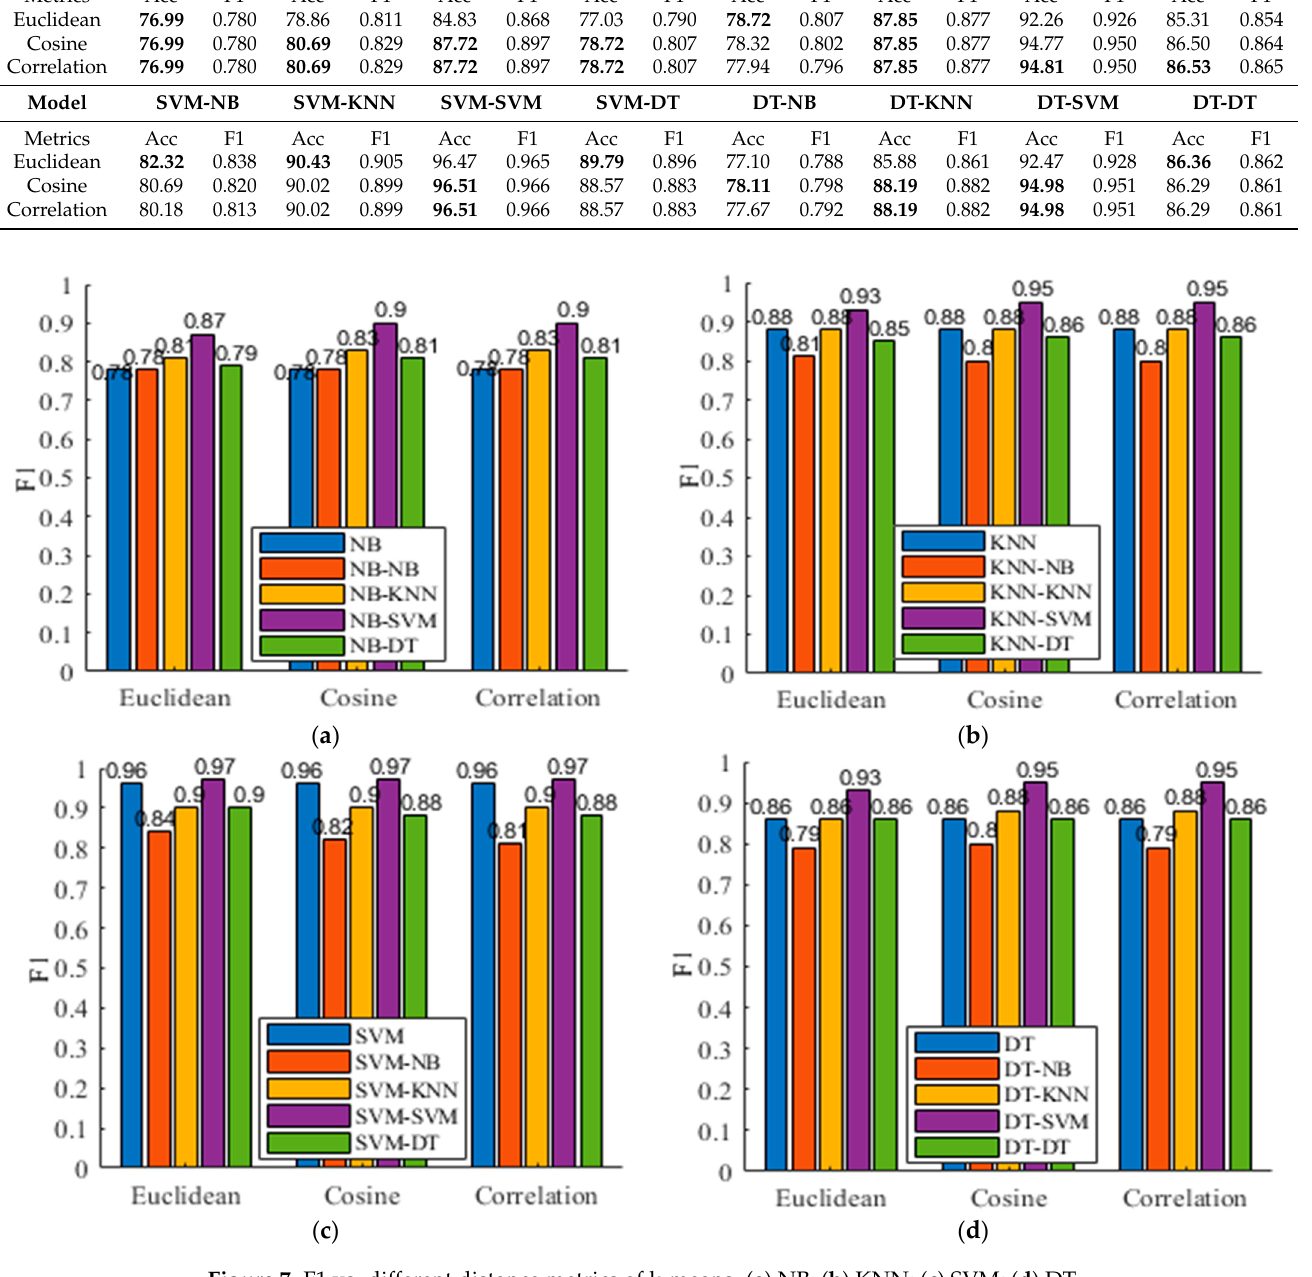
Figure 7. F1 vs. different distance metrics of k -means. ( a ) NB; ( b ) KNN; ( c ) SVM; ( d ) DT.